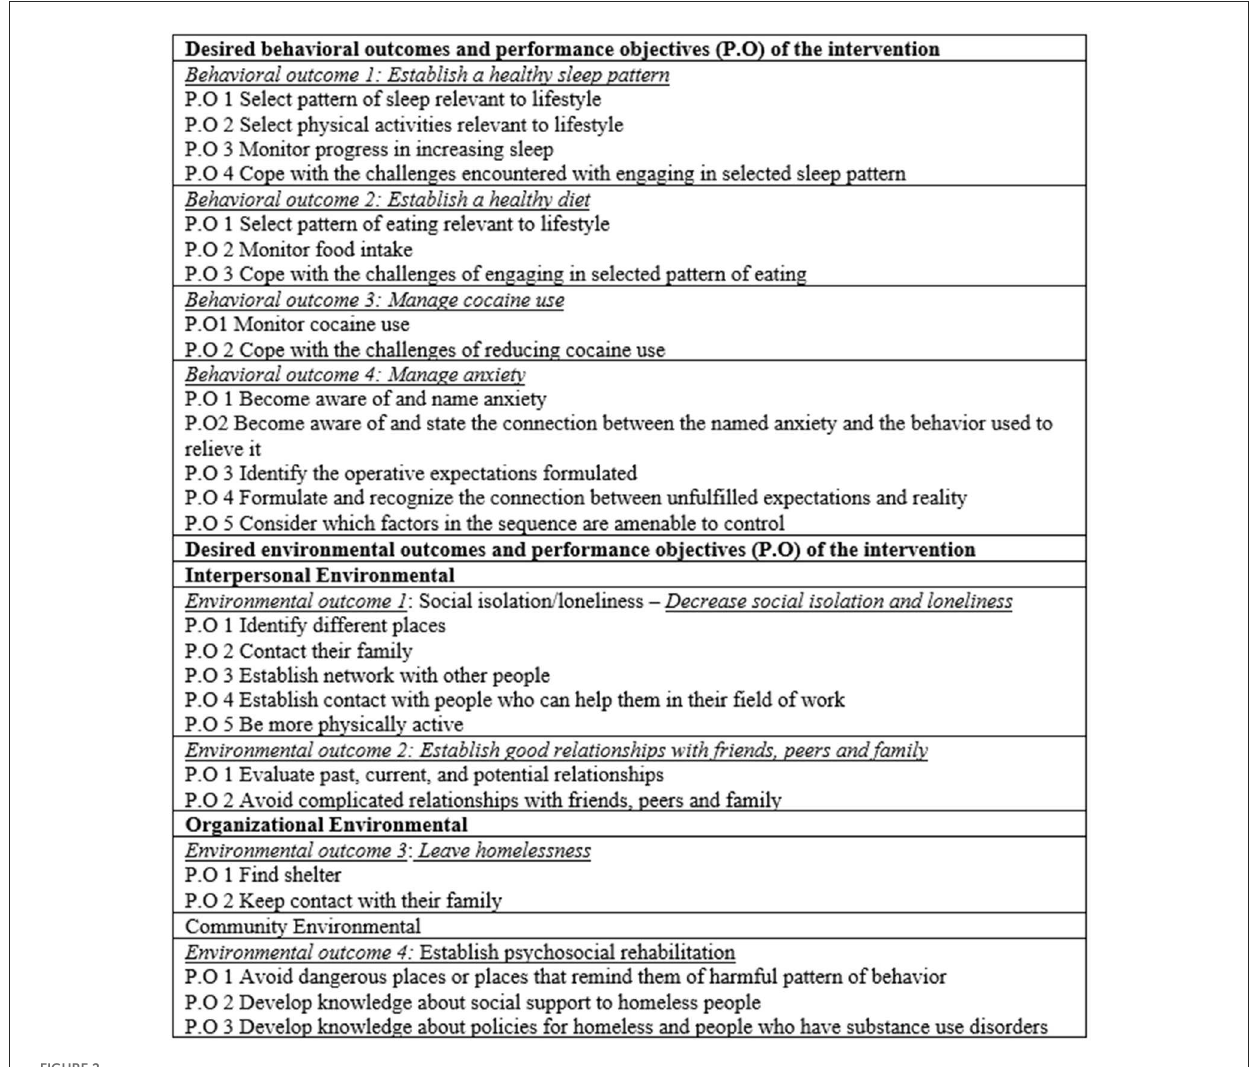
FIGURE2 Expected outcomes for behavioral and environmental